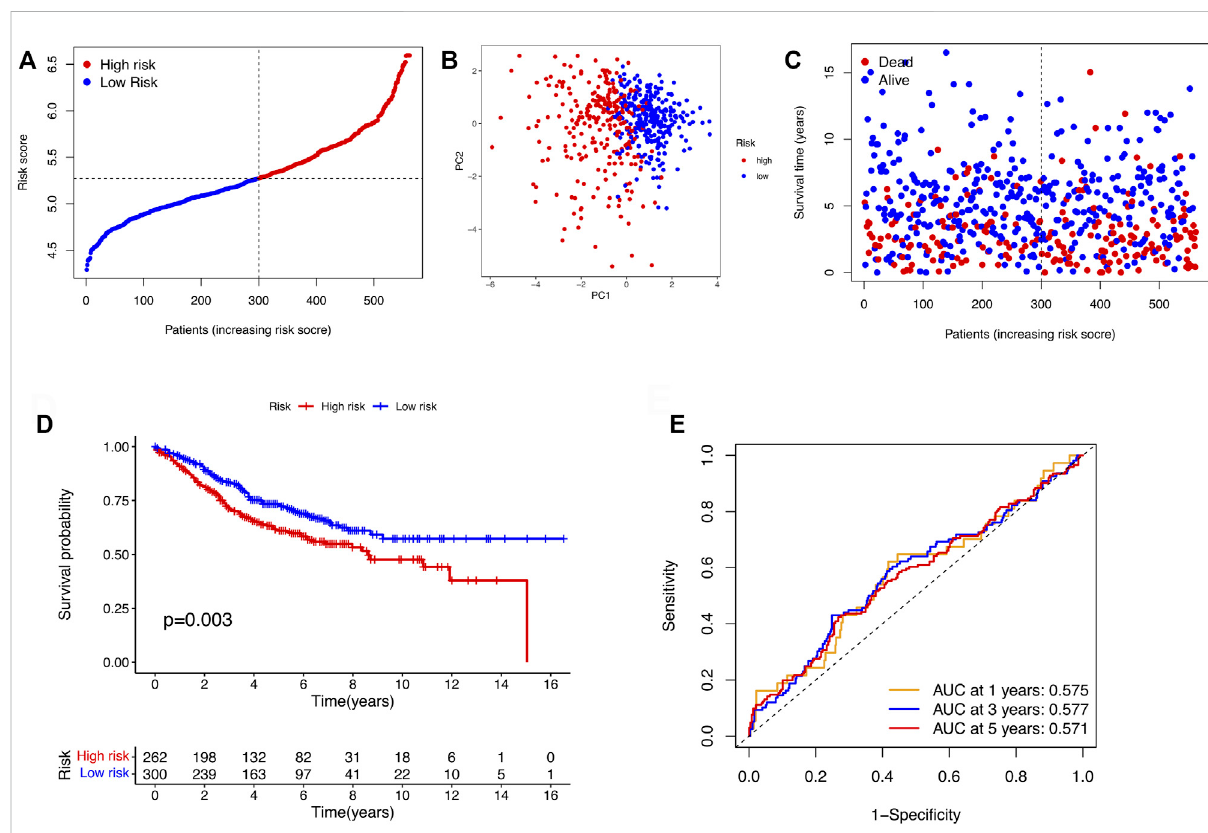
FIGURE 4 Validation of the risk models in the GSE39582 cohort. (A) Distribution of samples in the GSE39582 cohort based on the median risk score in the TCGA cohort. (B) PCA plot of the GSE39582 cohort. (C) The survival status for COAD patients. (D) KM survival curve for the OS of patients between the two risk groups in the GSE39582 cohort. (E) ROC curves veri fi ed the prognostic performance of the model in the GSE39582